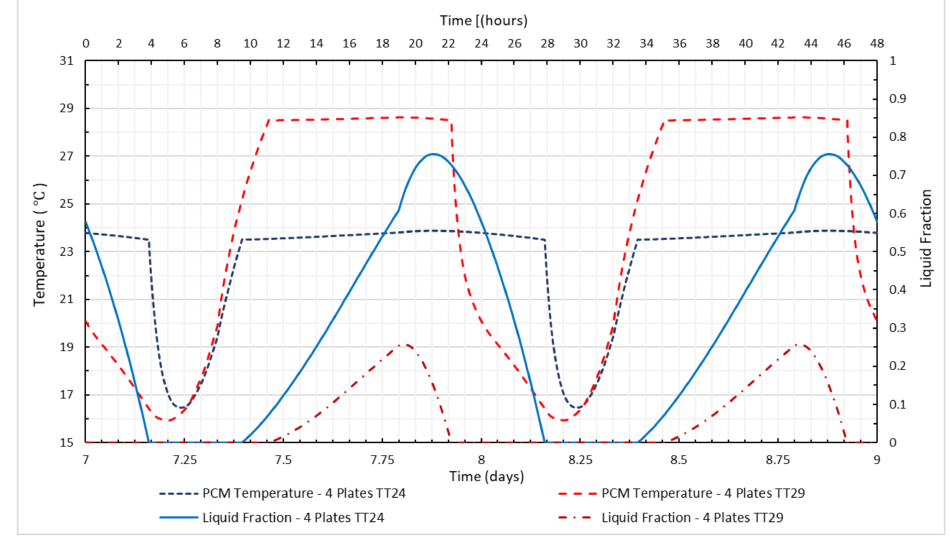
Figure 9. PCM temperature and liquid fraction for the room in low inertia configuration, during normal summer conditions, with natural